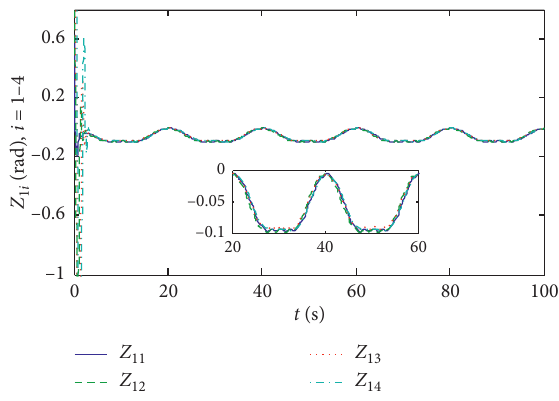
Figure 5: The auxiliary variables Z